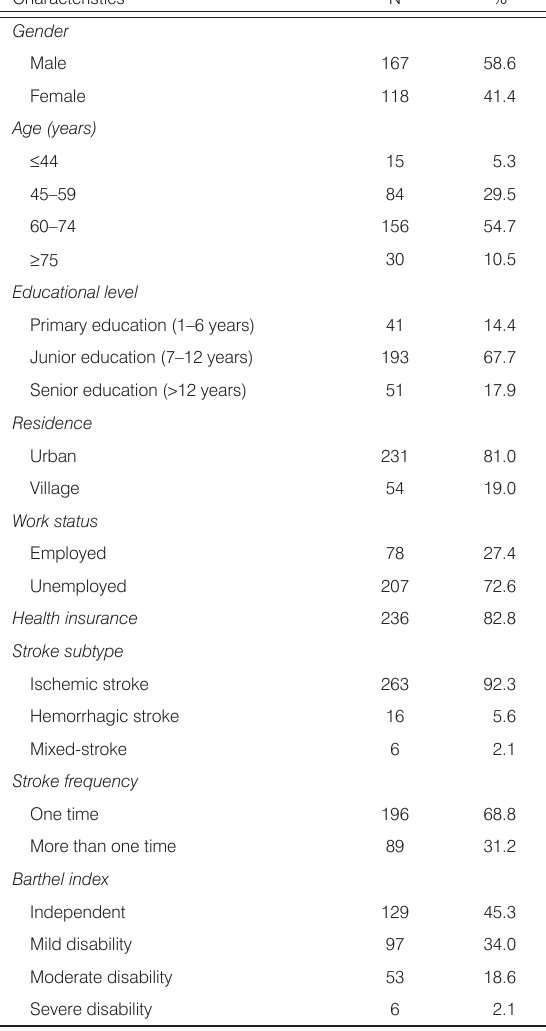
Table 1. Participants’ characteristics ( N = 285).